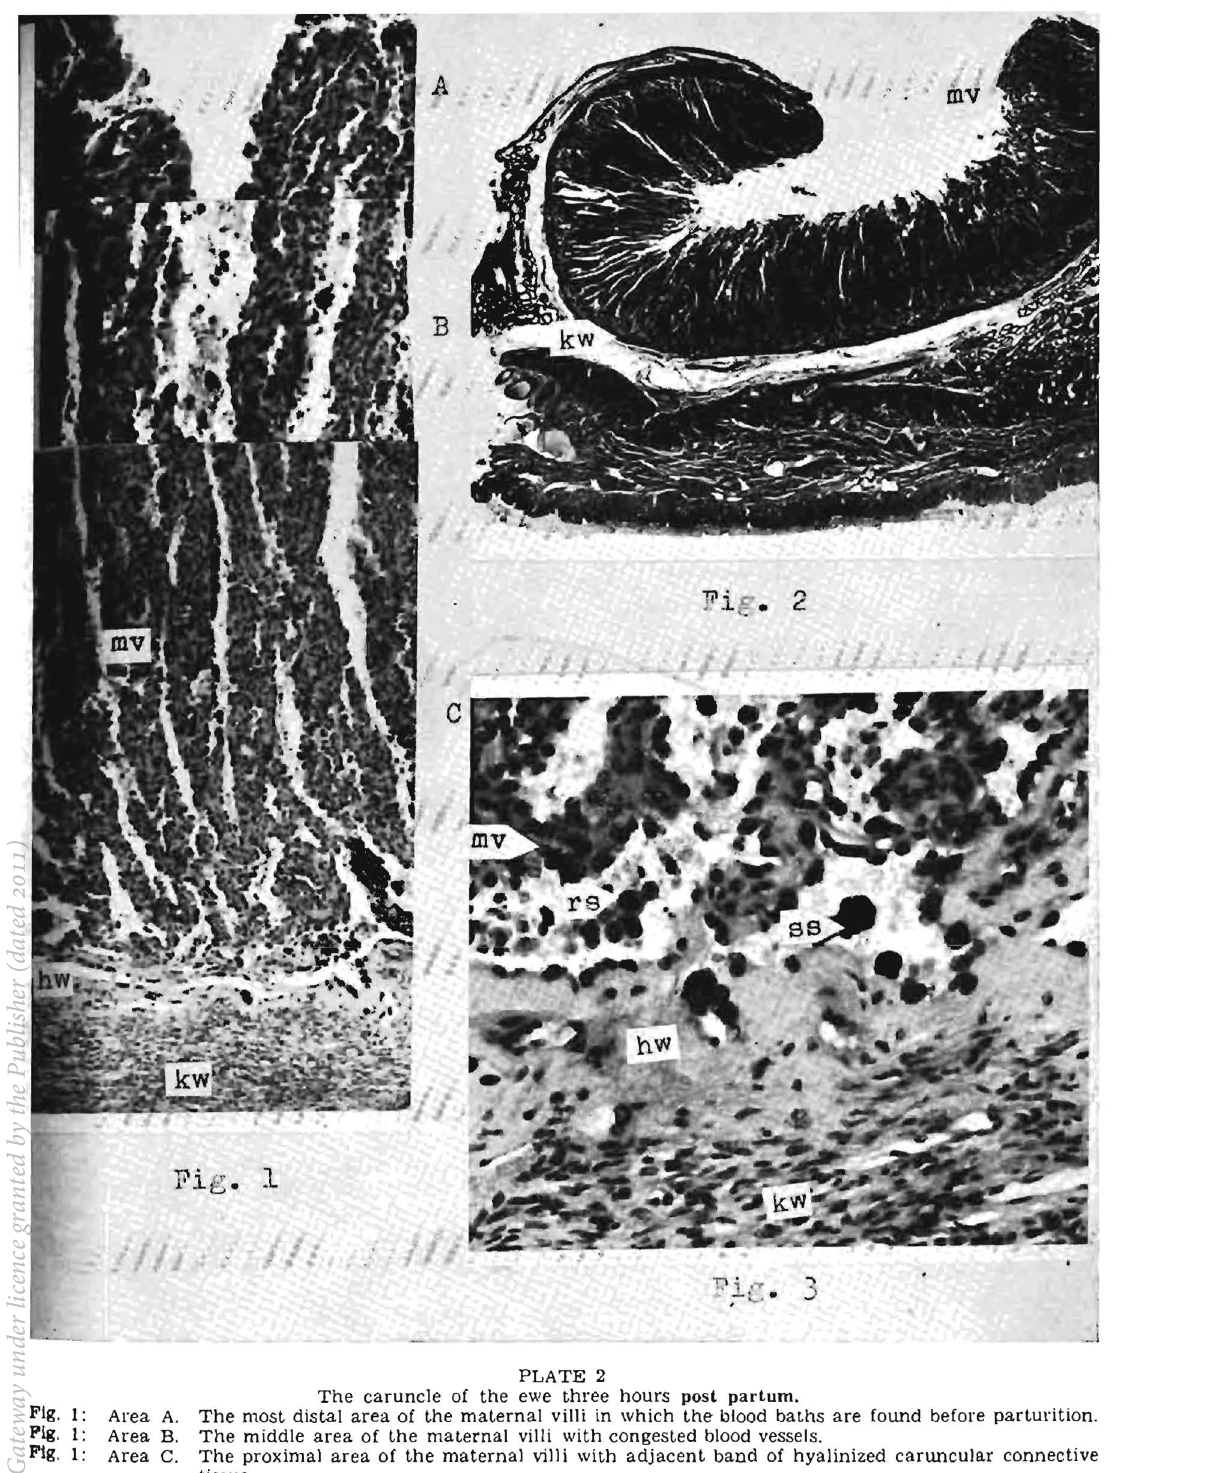
Area A. Area B. Area